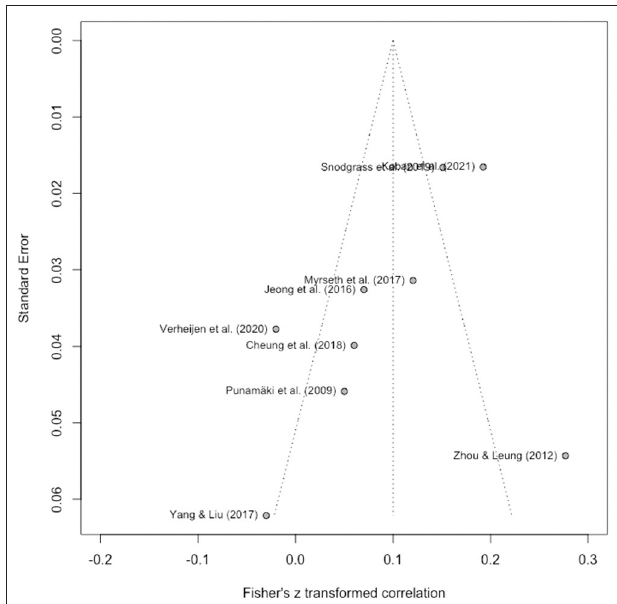
FIGURE 3 | Funnel